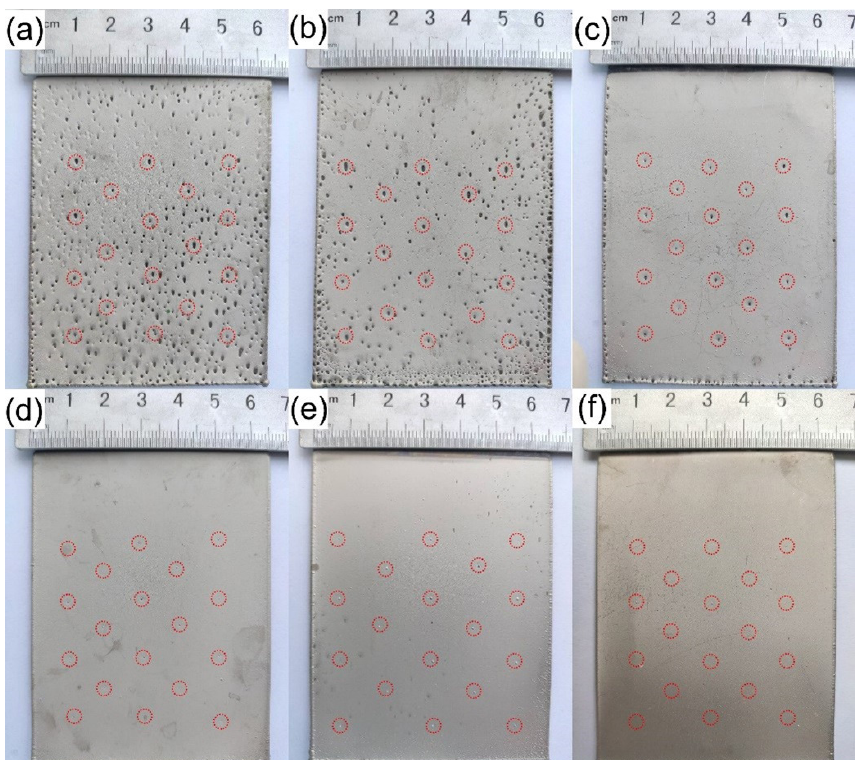
Figure 2. Digital photo of the electrodeposition sample produced as Table 1. Content of SDS (g/L): ( a ) 0.0020 g/L; ( b ) 0.0040 g/L; ( c ) 0.0050 g/L; ( d ) 0.0060 g/L; ( e ) 0.0080 g/L; ( f ) 0.0100 g/L.